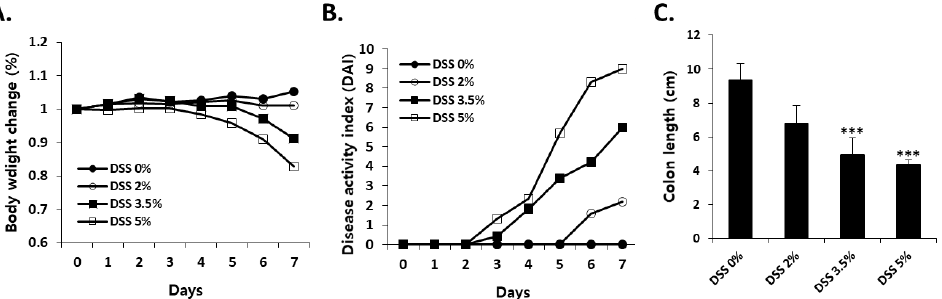
Figure 1. Assessment of ( A ) body weight change, ( B ) disease activity index (DAI), and ( C ) colon length in dextran sodium sulfate (DSS)-treated mice. Mice were given 2%, 3.5%, and 5% DSS in drinking water for 7 days. Each value is presented as the mean ± SD for six mice. *** Significantly different from the control (DSS 0%) (Student’s t-test, p < 0.001).